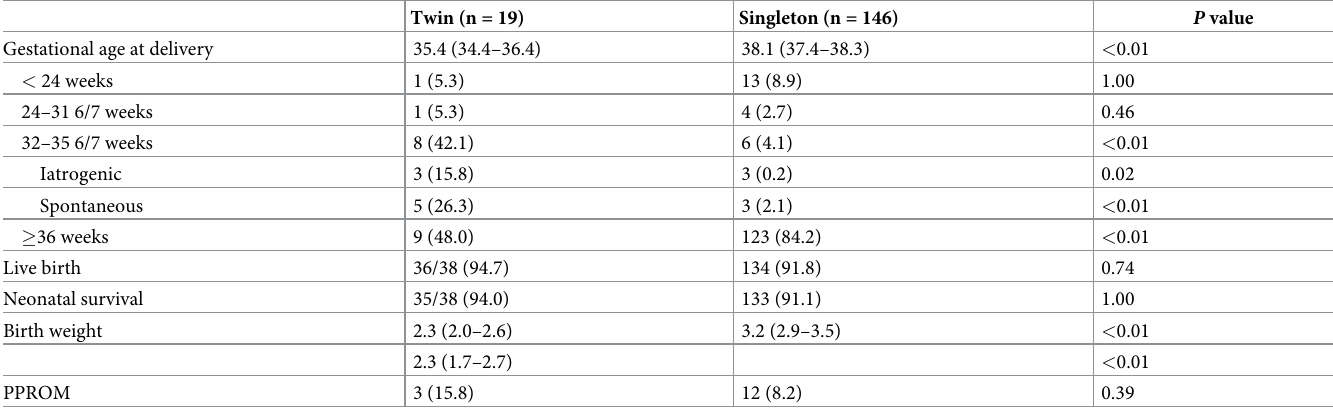
Pregnancy outcomes following TAC are presented in Table 3. Gestational age at delivery differed between the two groups, with twins delivering at a median 35.4 weeks (IQR, 34.4– 36.4) compared with singletons at 38.1 weeks (IQR, 37.4–38.3) (P < 0.01). Rates of delivery before 24 and 32 weeks did not differ. Thus, this difference was primarily related to differences in delivery at gestational ages later than 32 weeks. Women with twins delivered more likely Table 3. Pregnancy outcomes of transabdominal